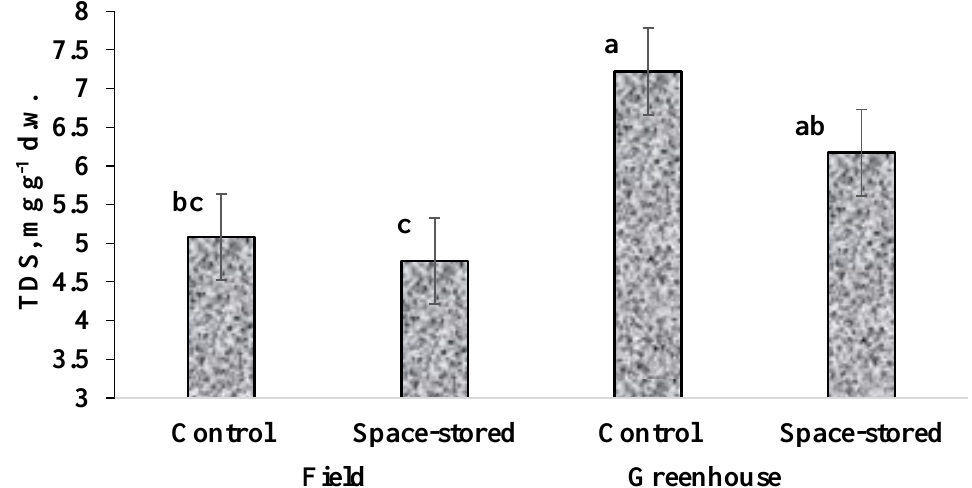
Figure 1. TDS content in tomato fruits grown from control and spaceflight-exposed seeds, in open field and in greenhouse. Values with the same letters do not differ statistically according to Duncan test at p < 0.05.